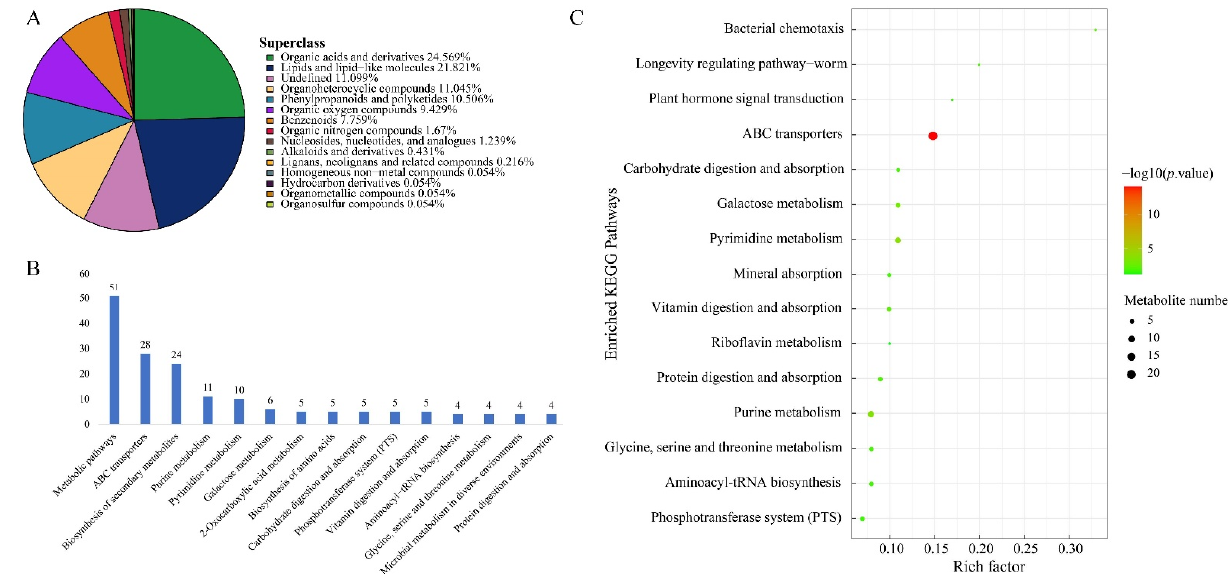
Figure 1. Annotation and enrichment analyses of U. hordei responsive metabolome. ( A ) statistic of identified metabolites. Different superclasses show in various colors; ( B ) statistic of annotated KEGG pathways of metabolites; ( C ) KEGG enrichment analysis, hypergeometric tests were performed based on the KEGG classification of significant different metabolites. Abscissa is a rich factor which is defined as the ratio of different metabolites number and the number of genes has been annotated in this pathway; point size represents metabolite number; p value, shown by color from green to red.